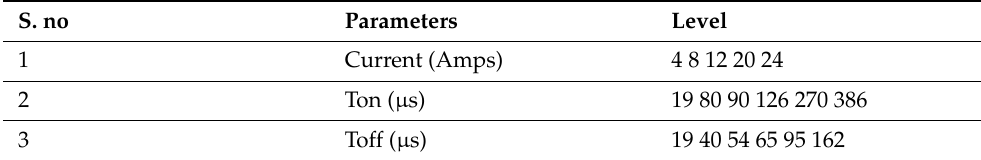
Table 2. Experimental